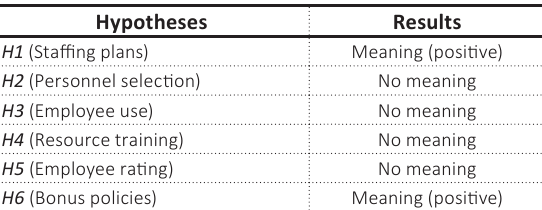
Table 7. Hypotheses testing results